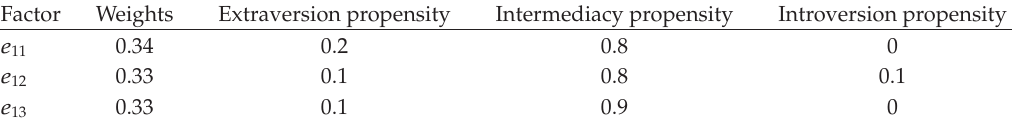
Table 2: Evaluation information of “reaction judgment